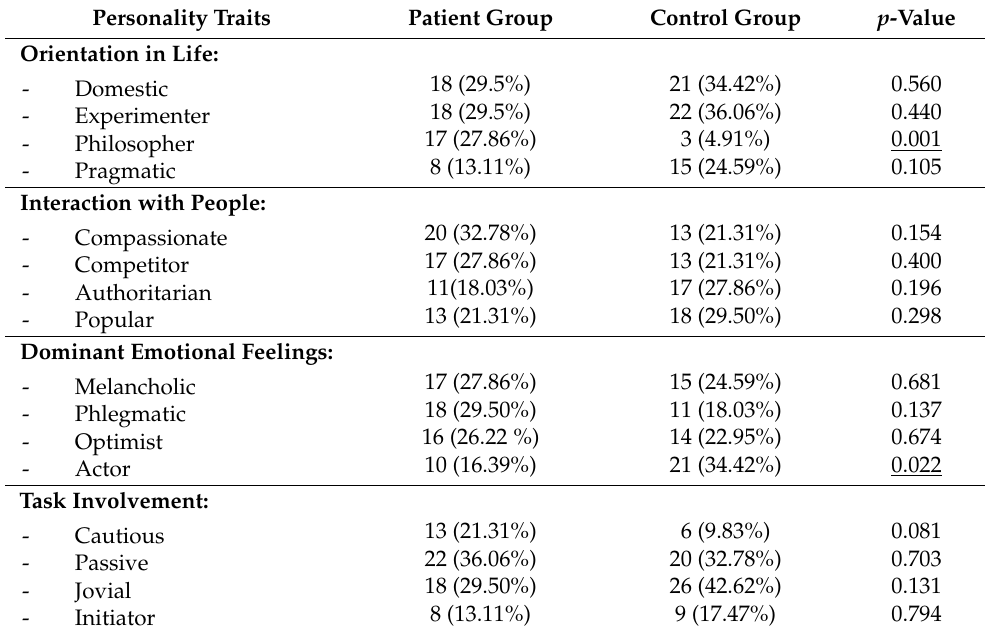
Table 4. Personality